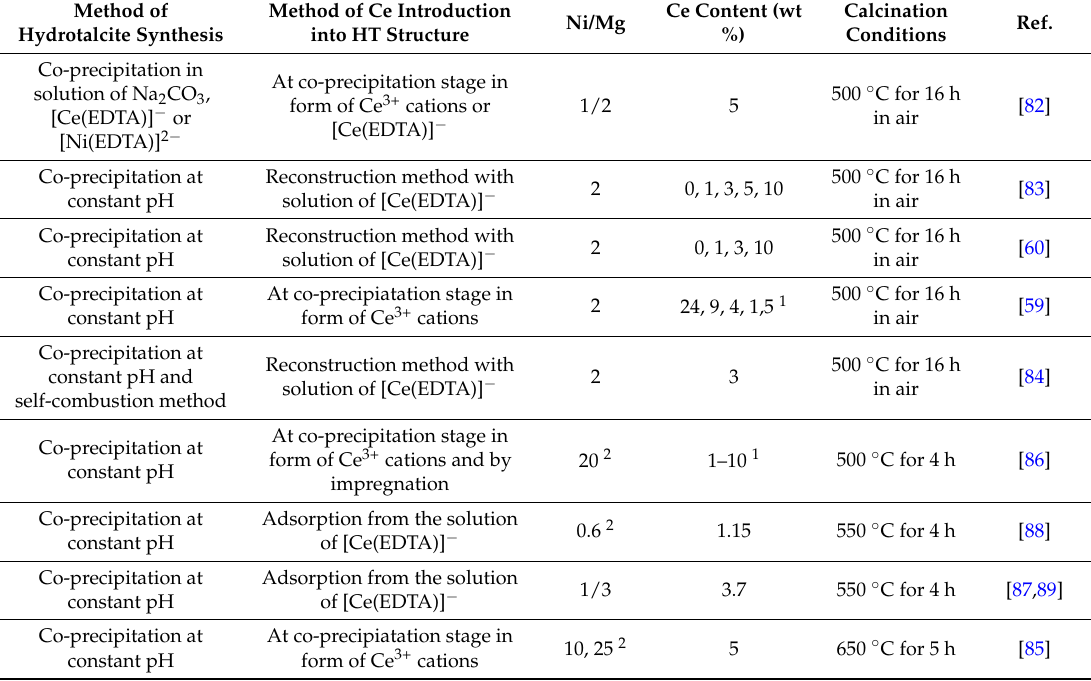
Table 4. Methods of ceria introduction into Ni/Mg/Al hydrotalcite-derived mixed oxides tested in